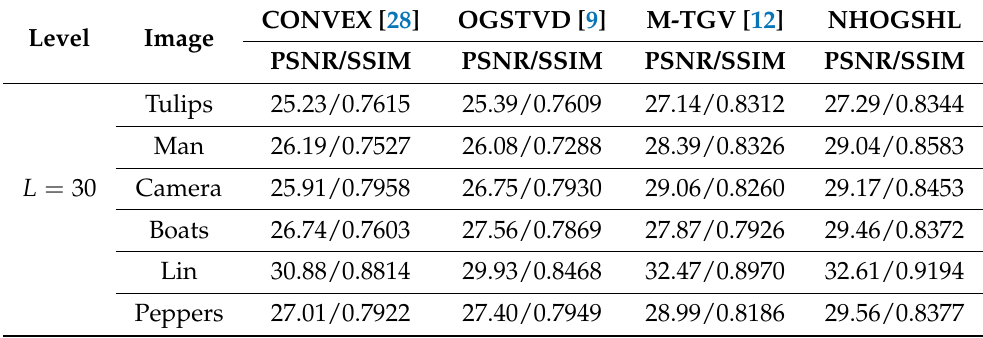
Table 1. Summary of the results of PSNR values and SSIM values restored by different algorithms under the noise level of L = 30.